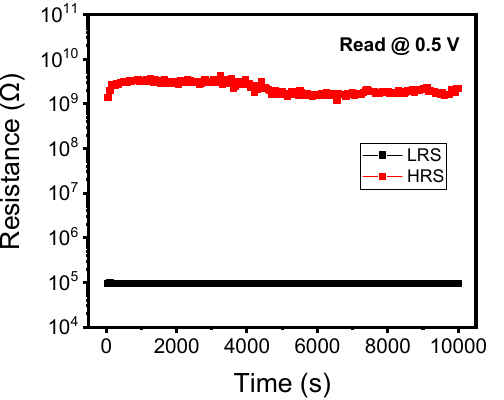
Figure 4. Retention test of Au/Ti/HfTiO x /p-Si device in the low-resistance state (LRS) and high- resistance state (HRS) for 10,000 s.